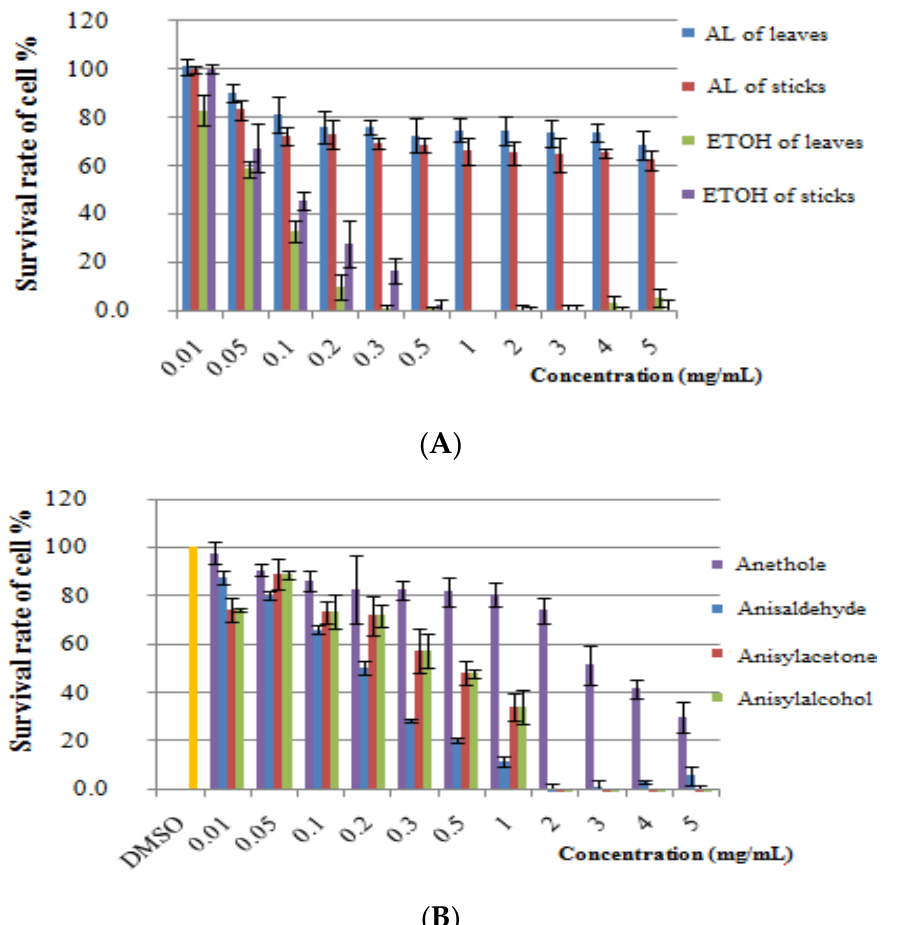
Figure 2. Cytotoxicity assay. ( A ): the various extracts; ( B ): the standard substances.